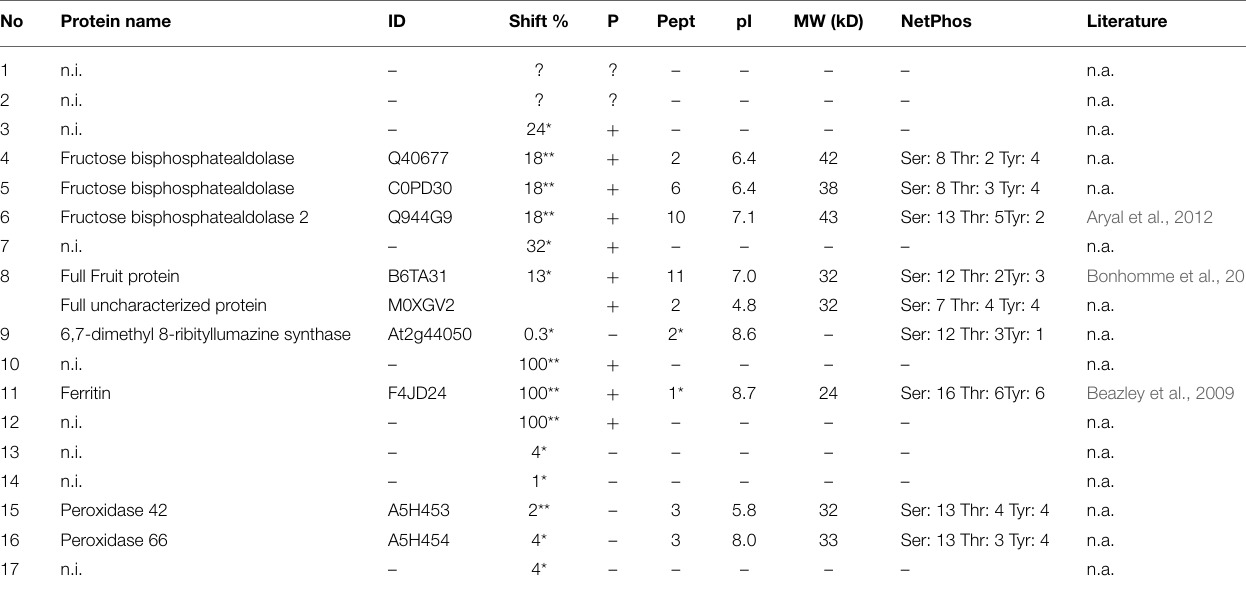
TABLE 1 | Identified